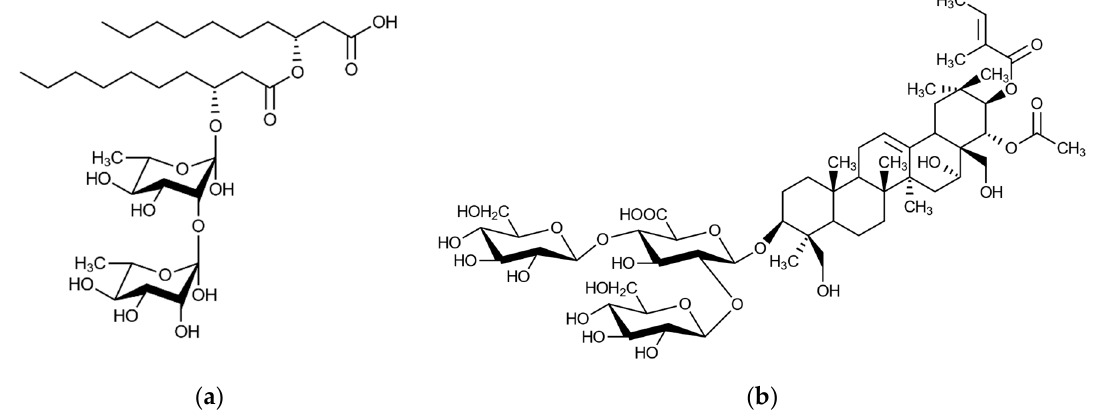
Figure 4. Molecular structures of rhamnolipid from P. aeruginosa ( a ) and horse-chestnut escin ( b ).